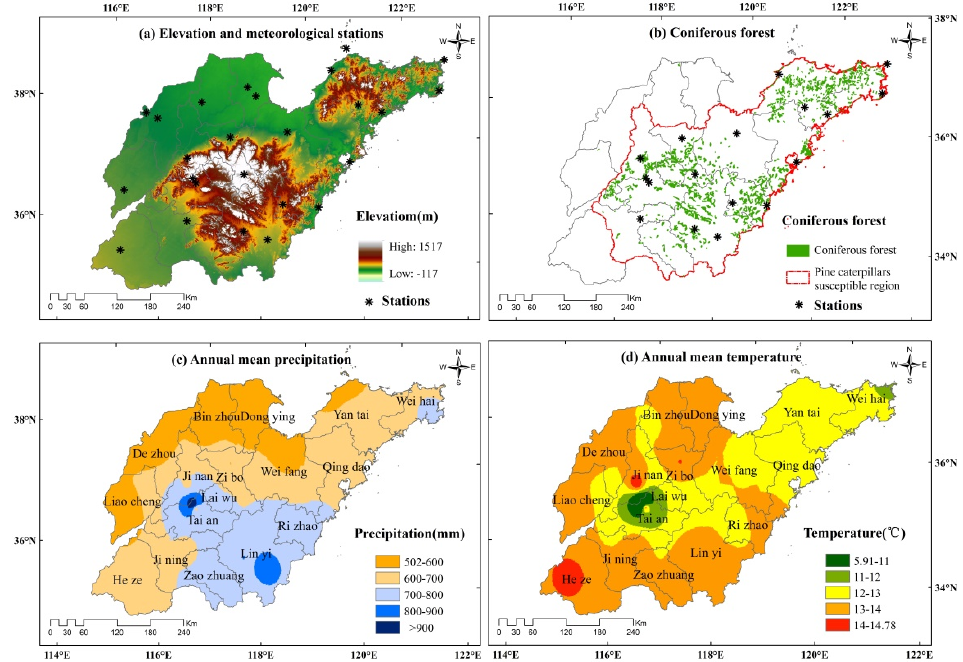
Figure 1. Basic characteristics of Shandong Province, China: Elevation ( a ), coniferous forest ( b ), annual mean precipitation from 1981 to 2012 ( c ), and annual mean temperature from 1981 to 2012 ( d ).